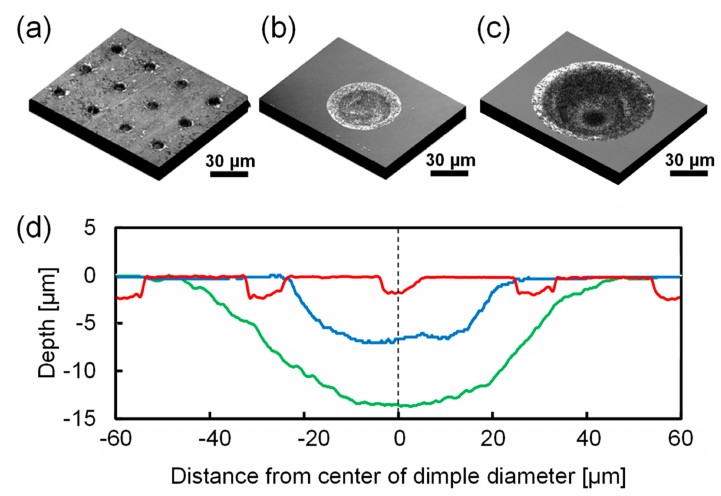
Figure 2. Confocal laser scanning microscope images of the laser textured dimple cell with a diameter of ( a ) 10 µ m, ( b ) 50 µ m, ( c ) 100 µ m and ( d ) its surface line profiles.